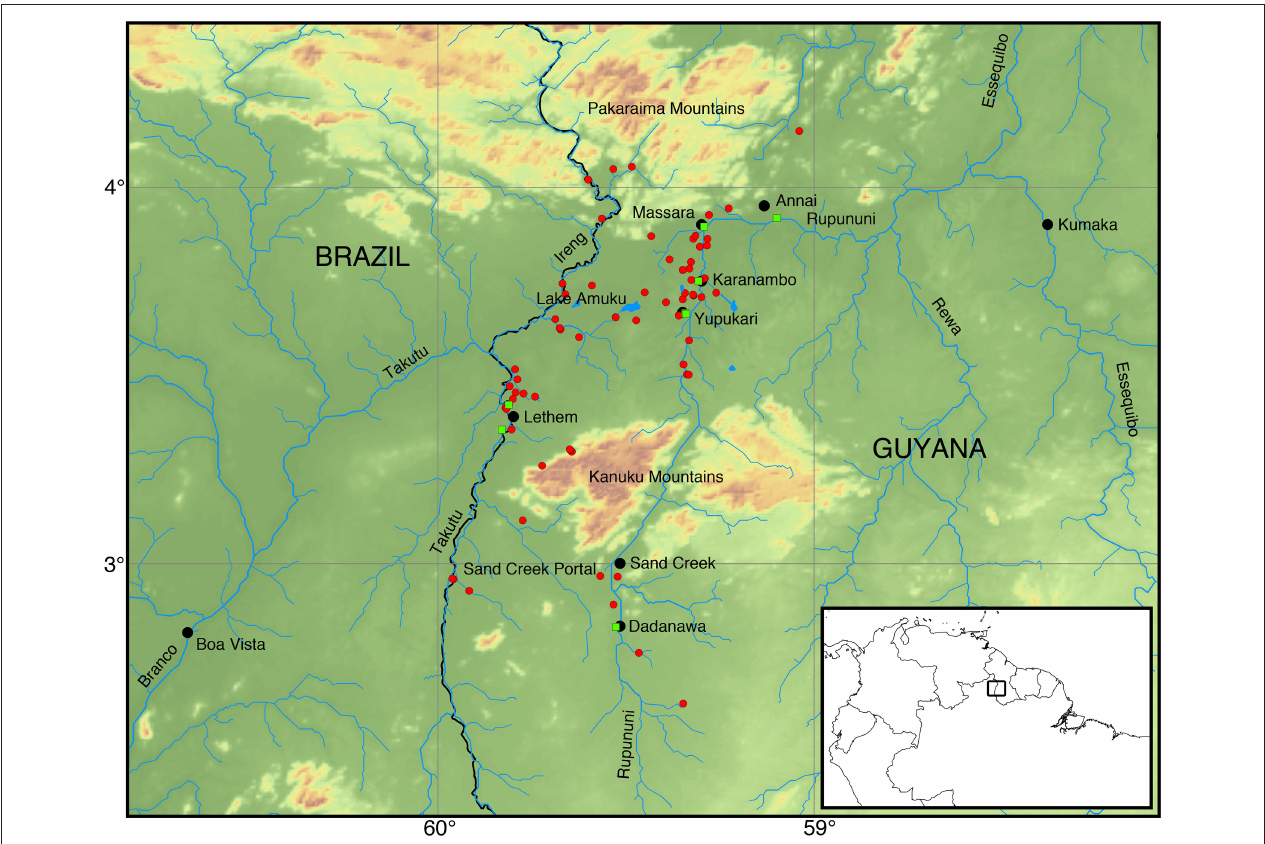
FIGURE 1 | Map of the Rupununi region with red circles and green squares that represent collecting sites in the Rupununi. The green squares are sites with highest fish diversity. Lake Amuku represents the area that floods to provide the corridor between the Takutu and Rupununi rivers to form the Rupununi Portal. Location of the Sand Creek Portal is indicated and detailed further in Figure 5